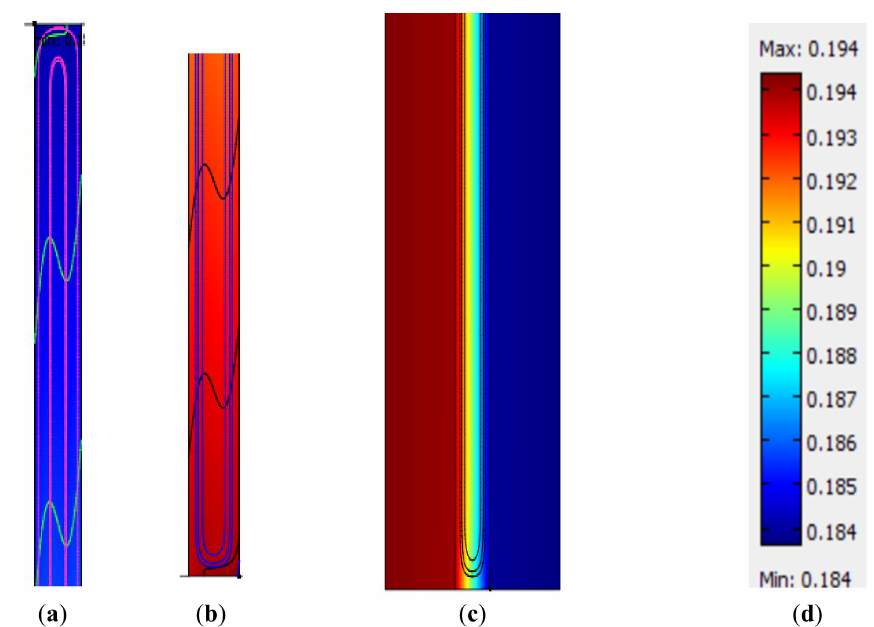
Figure 8. Stream function, the iso-mass fraction lines and mass fraction field: upper ( a ) and lower ( b ) parts of the TGC and inside the binary fluid. ( c ) Thermal field in the cell and the bounding plates, in the lower part of the TGC and streamlines inside the binary fluid toluene–methanol. ( d ) Mass fraction field scale. ∆ T = 6 ◦ C ( T h = 26 ◦ C, T c = 20 ◦ C )